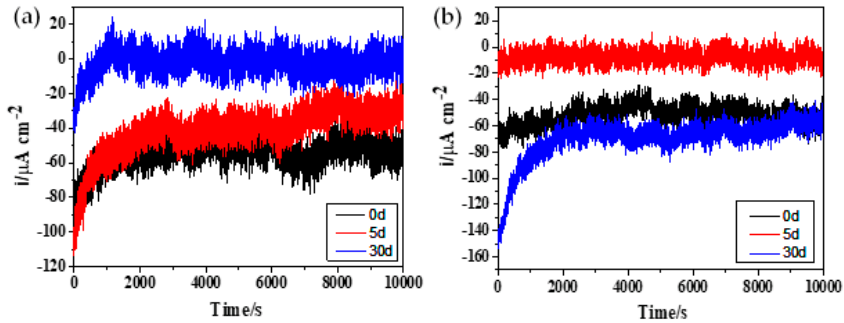
Figure 6. Current density fluctuation for AA6061 ‐ T3 immersed in Caribbean seawater up to 30 days under ( a ) laminar and ( b ) stationary flows.